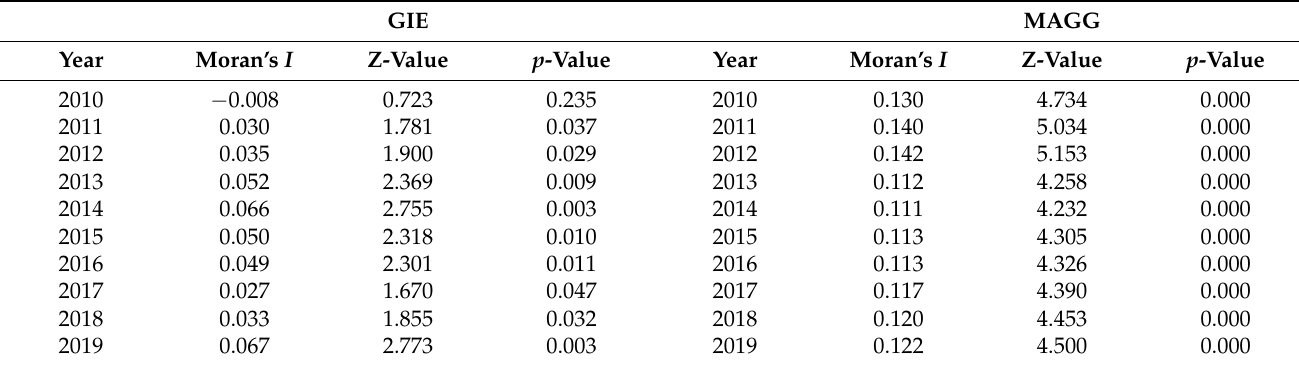
Table 6. Global Moran’s I Index of GIE and MAGG. GIE MAGG